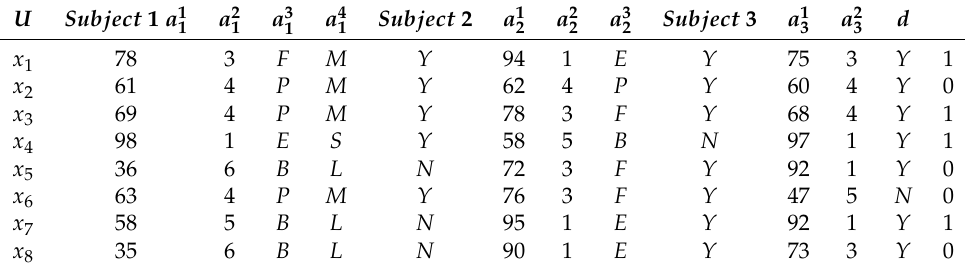
Table 3. A generalized multi-scale information